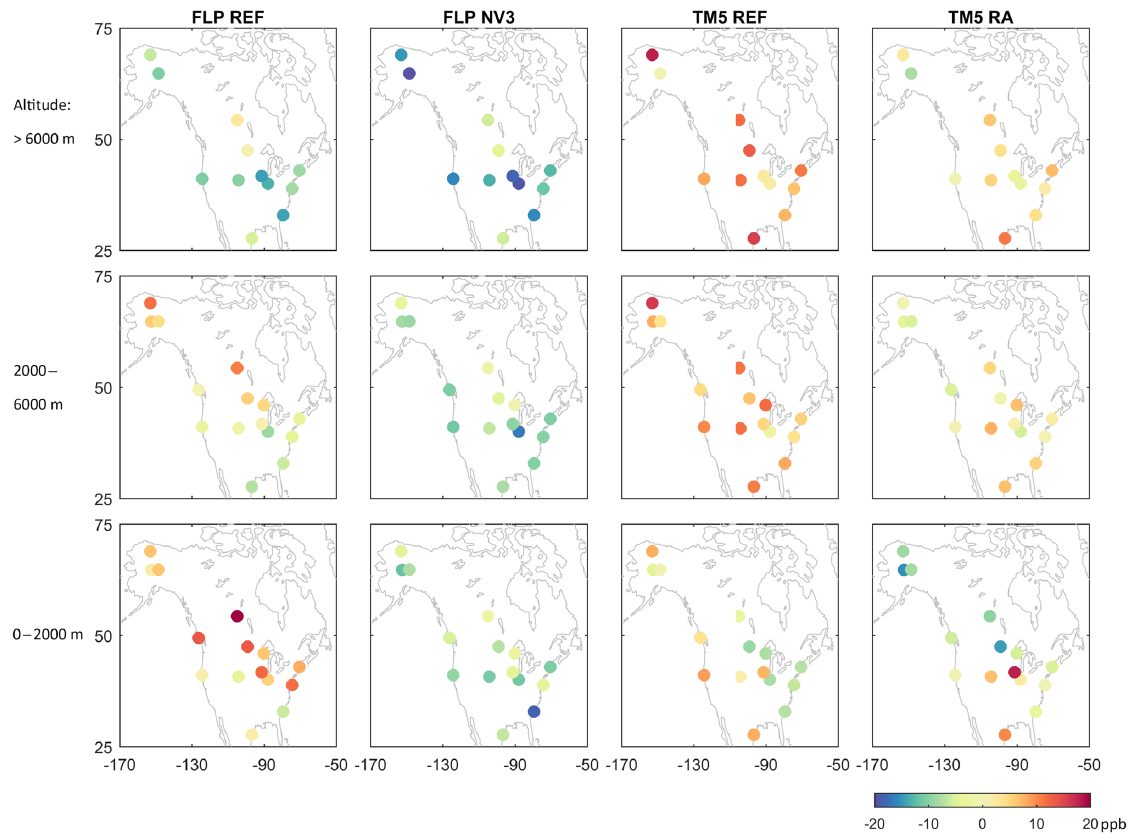
Figure 13. Model bias of FLEXPART CTM (abbreviated FLP) and TM5 at three altitude ranges for NOAA profiles in 2013 in North